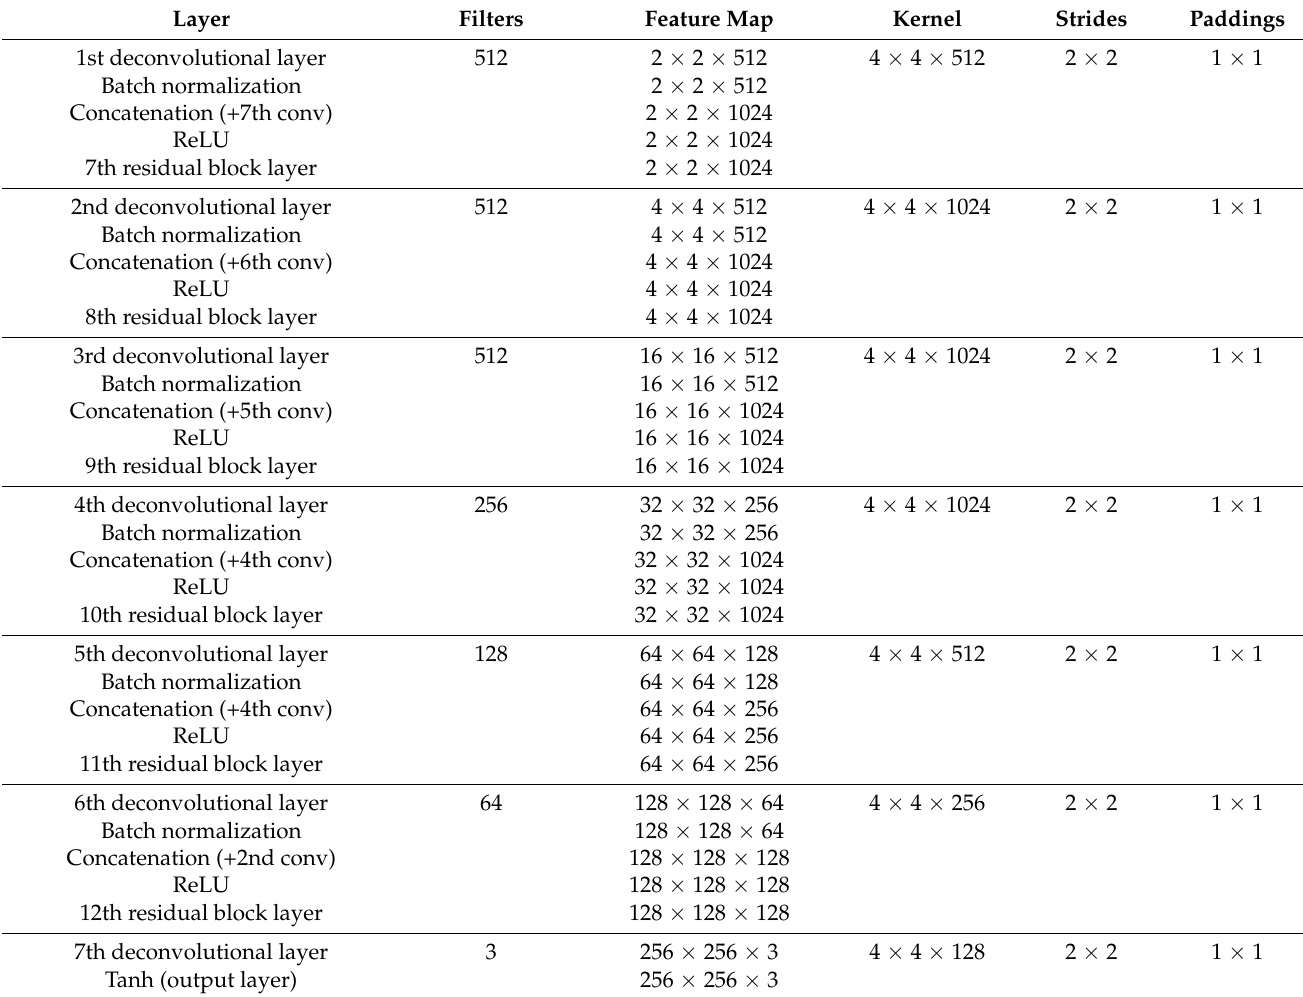
Table 2. Decoder architecture parameters for the proposed generator network.